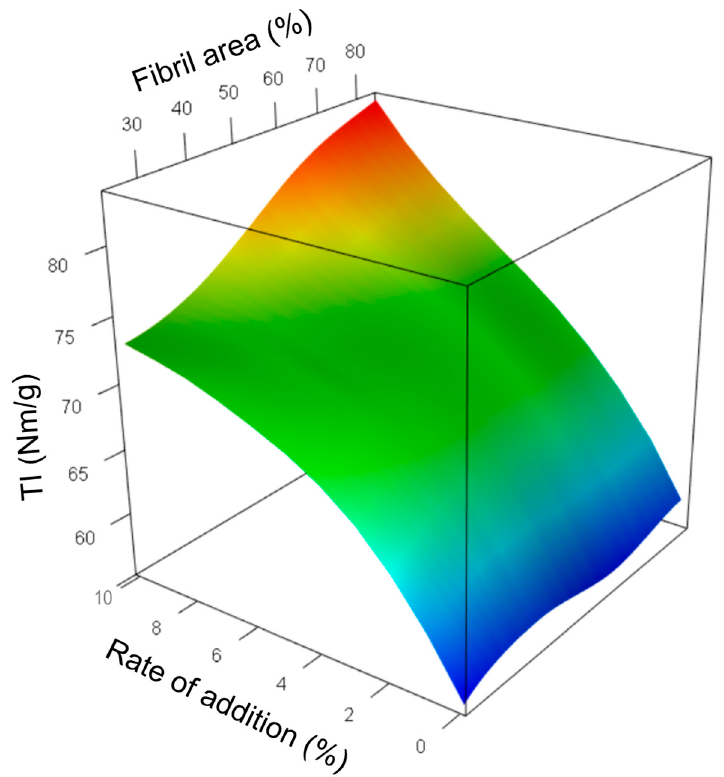
Figure 9. Combined influence of the morphological characteristics of the added materials and rate of addition on paper mechanical properties. Effect of fibril area and rate of addition on tensile index (TI).